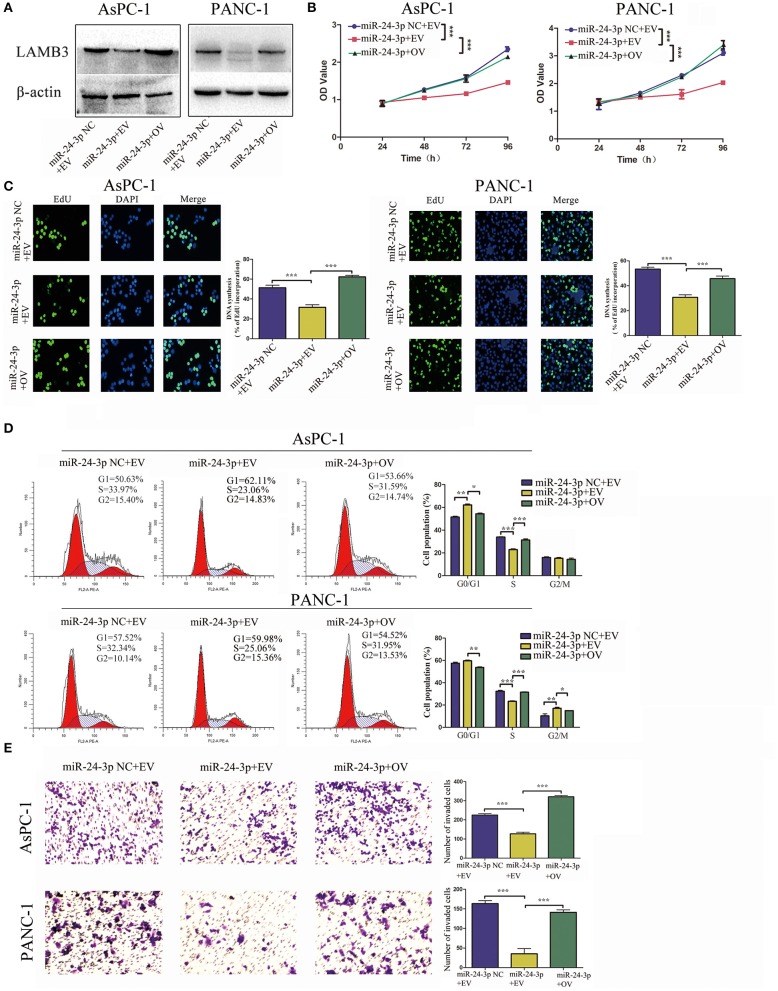
MiR-24-3p overexpression inhibits tumor progression, which is recovered by the reintroduction of LAMB3. (A) LAMB3 expression levels were determined using Western blotting in cells transfected with miR-24-3p mimics and LAMB3 overexpression vector (OV). Cells transfected with LAMB3 empty vector (EV) and mimics NC were used as the negative controls. (B,C) CCK-8 and EdU assays showed that miR-24-3p overexpression inhibited cell proliferation, whereas overexpression of LAMB3 rescued the inhibitory effects. (D) Flow cytometry revealed that miR-24-3p overexpression induced cell cycle arrest, whereas overexpression of LAMB3 recovered the cell cycle period. (E) Transwell assays confirmed that miR-24-3p overexpression impaired the cell invasion capacity. Overexpression of LAMB3 resulted in enhanced cell invasion capacity. Data are presented as mean ± SD of three independent experiments; *p < 0.05, **p < 0.01, ***p < 0.001, paired t-test.